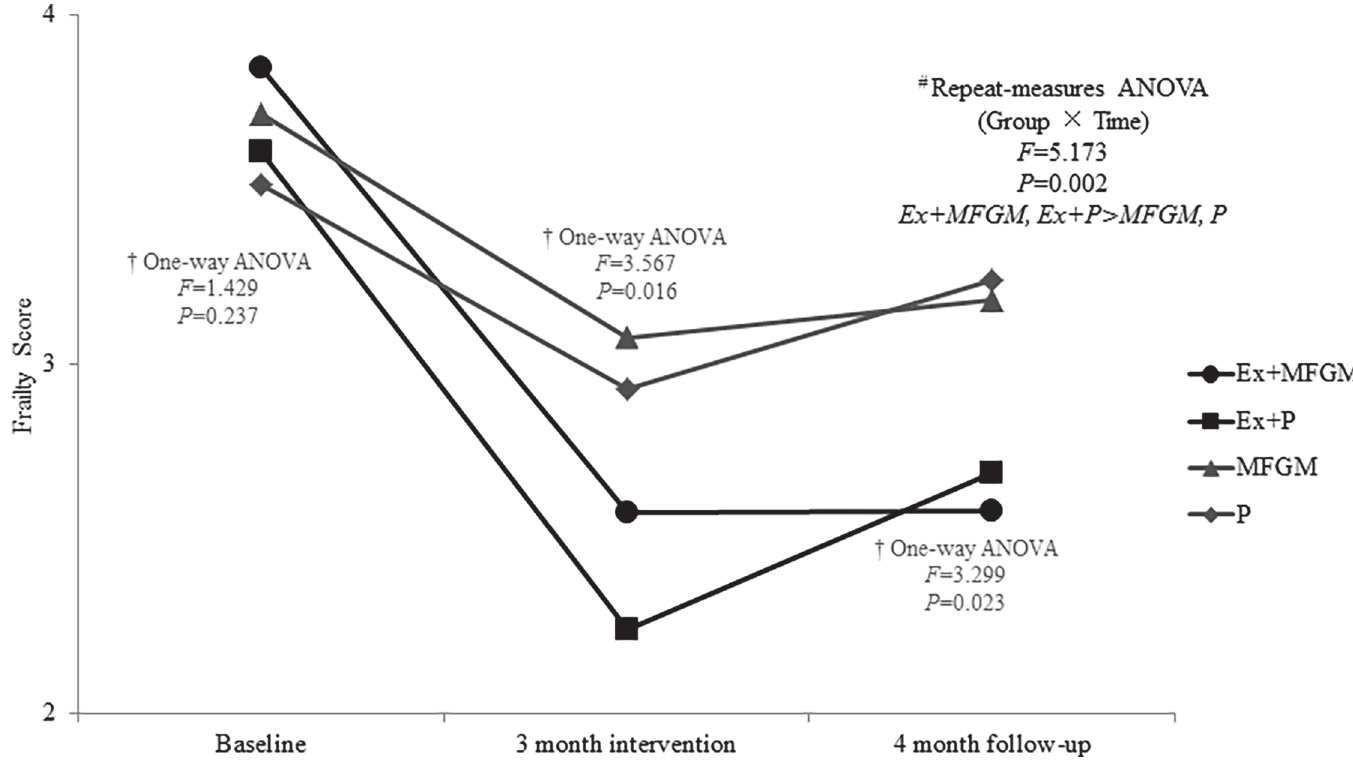
Fig 2. Changes of frailty score between baseline, post-intervention and follow-up. ANOVA = analysis of